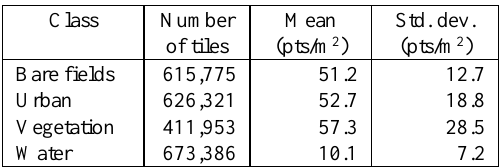
Table 3. Point density by